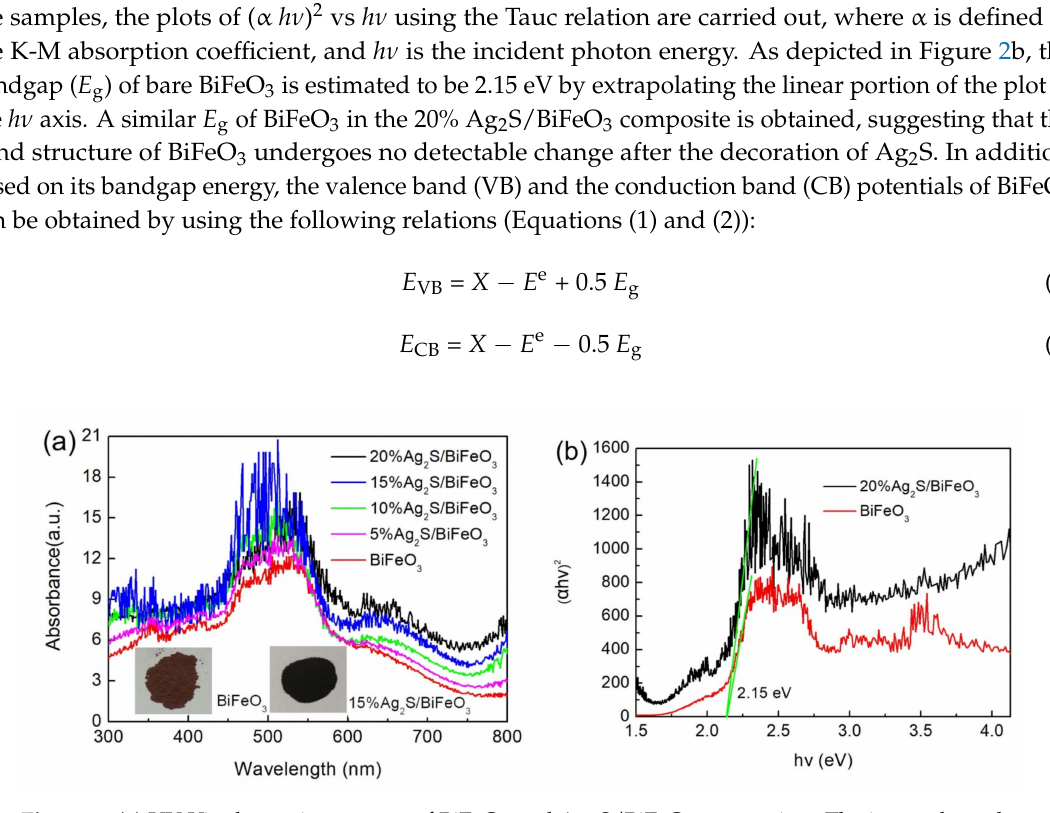
Figure 2. ( a ) UV-Vis absorption spectra of BiFeO 3 and Ag 2 S/BiFeO 3 composites. The insets show the digital images of BiFeO 3 and 15% Ag 2 S/BiFeO 3 . ( b ) The corresponding Tauc plots of ( α h ν ) 2 vs h ν for BiFeO 3 and 20% Ag 2 S/BiFeO 3